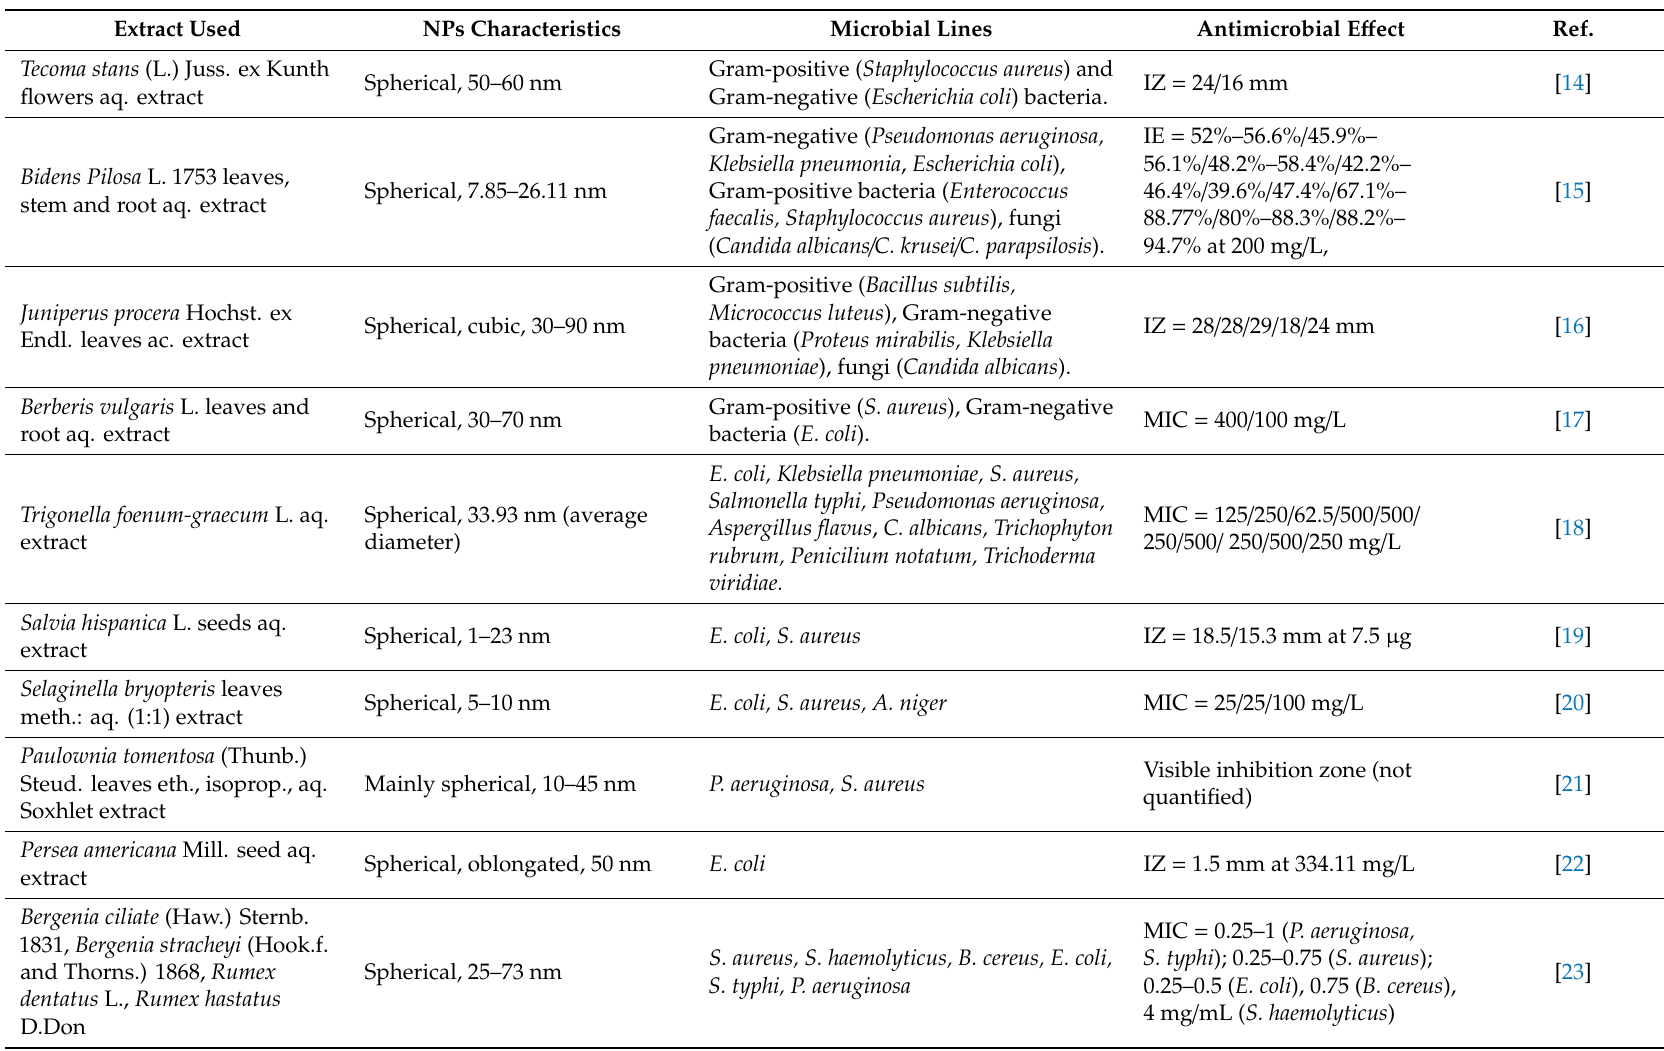
Table 1. Antimicrobial potential of phytosynthesized silver nanoparticles (as presented in studies published in